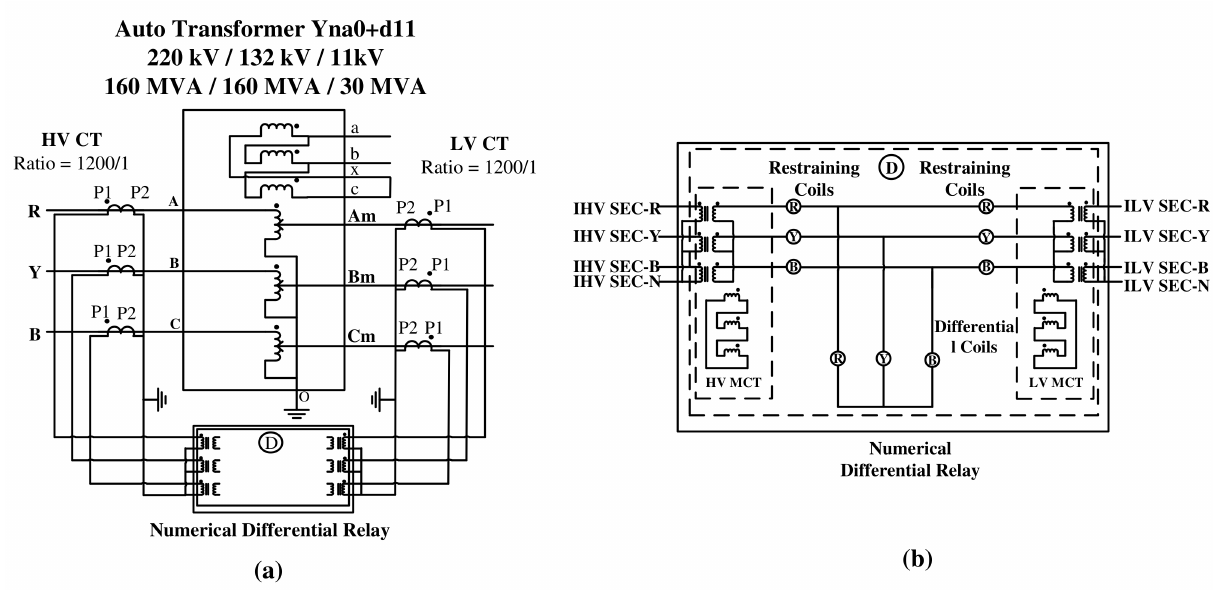
Figure 3. Differential relay circuit [24]: ( a ) connection diagram with two windings of transformer, and ( b ) matching CTs, restraining coils, and differential coils implemented in differential relay through